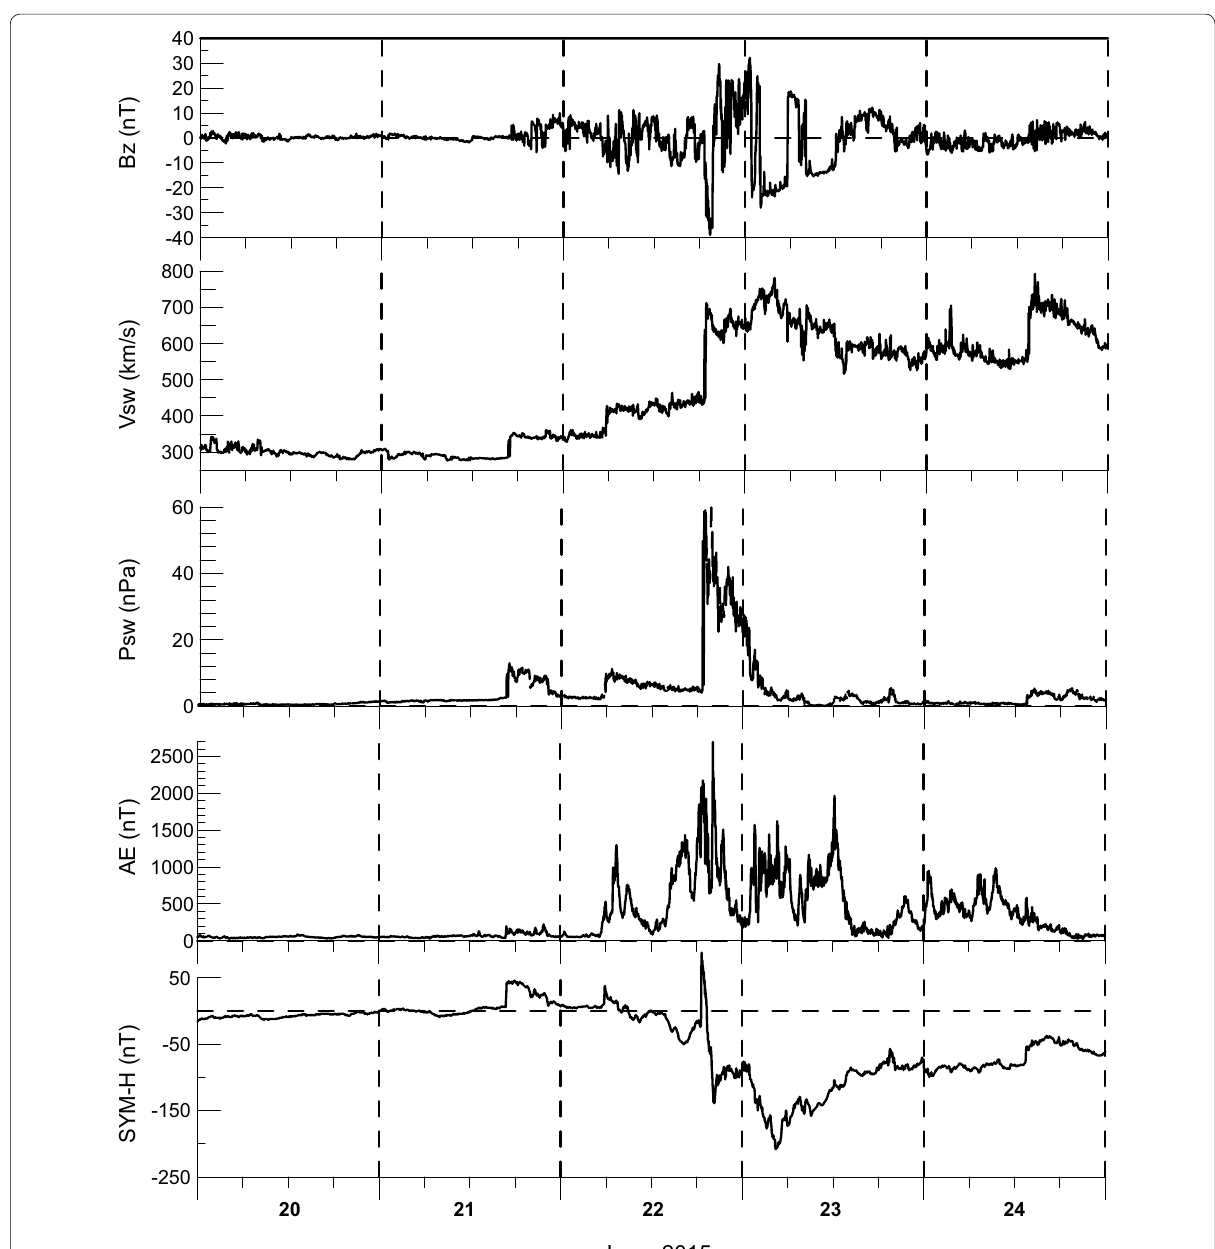
Fig. 1 Variations of the interplanetary and geomagnetic parameters during June 20–24, 2015, storm (from top to bottom ): IMF Bz component, velocity and dynamic pressure of the solar wind, auroral electrojet index AE and index of geomagnetic activity